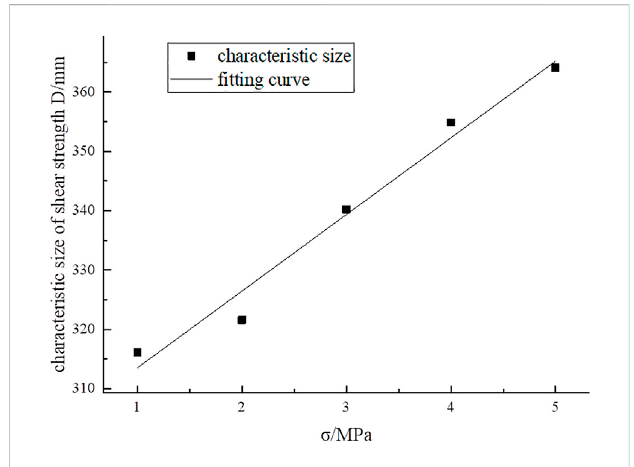
FIGURE 8 Fitting curve between the normal stress and characteristic